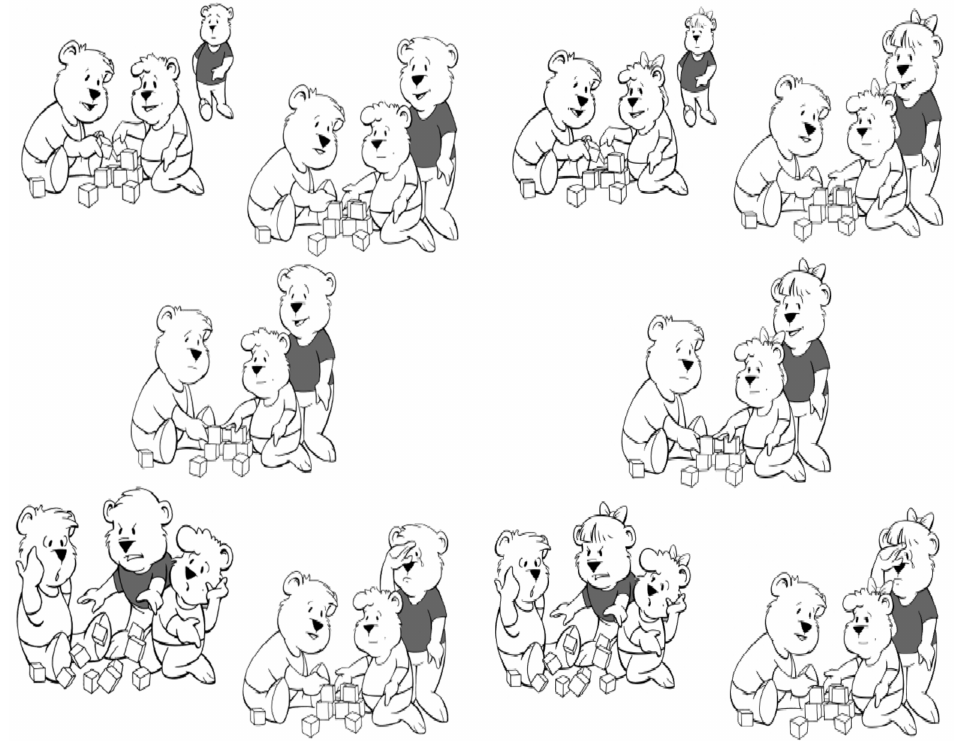
Figure A1. SIPI-P story: Peer entry example: Boys’ version on the left, girls’ version on the right—Story 1—Non-hostile exclusion. In the original measure, each picture appears on a separate page. Order of pictures: left to right, top to